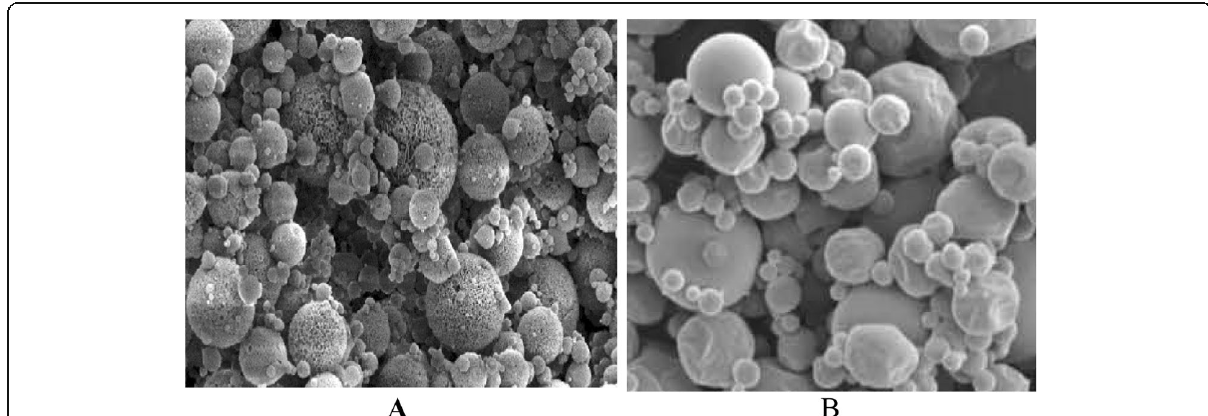
Fig. 4 SEM images of inulin powder. a Run 1 presenting the rough surface and b run 3 presenting the smooth surface of the particles